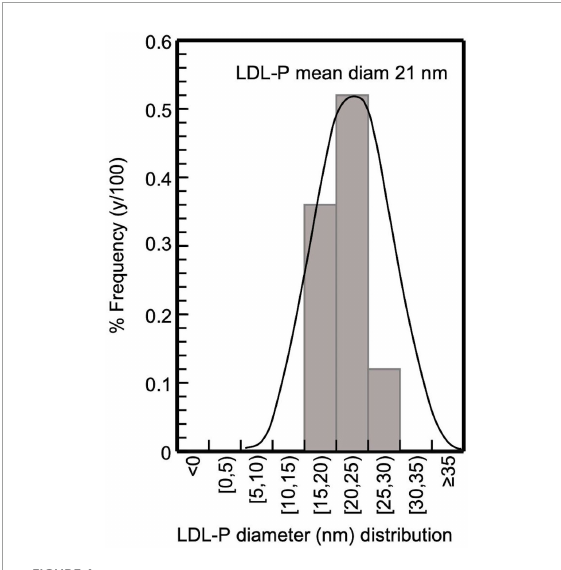
FIGURE4 Frequency histogram of LDL-P diameter in CKD-5d patients participating in the present study; 32 subjects with LDL-P 20–25 nm, 22 with 15–20 nm, and 7 with 25–30 nm, giving an average 21 nm.